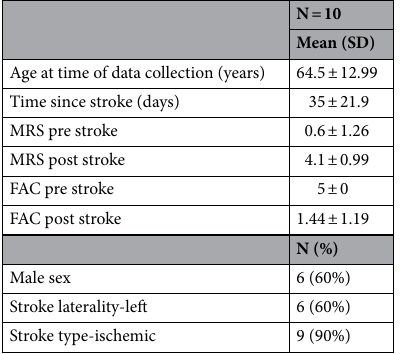
Table 2. Participant demographics and clinical